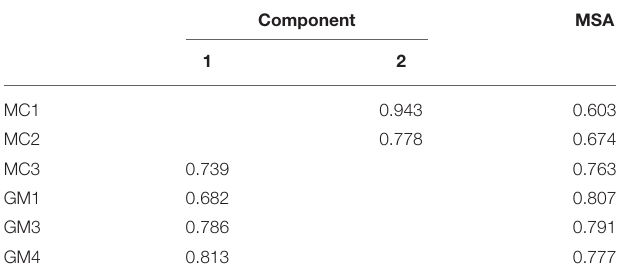
TABLE 6 | PCA on Meta-learning dimension items (6) for the CCI-21 36 items